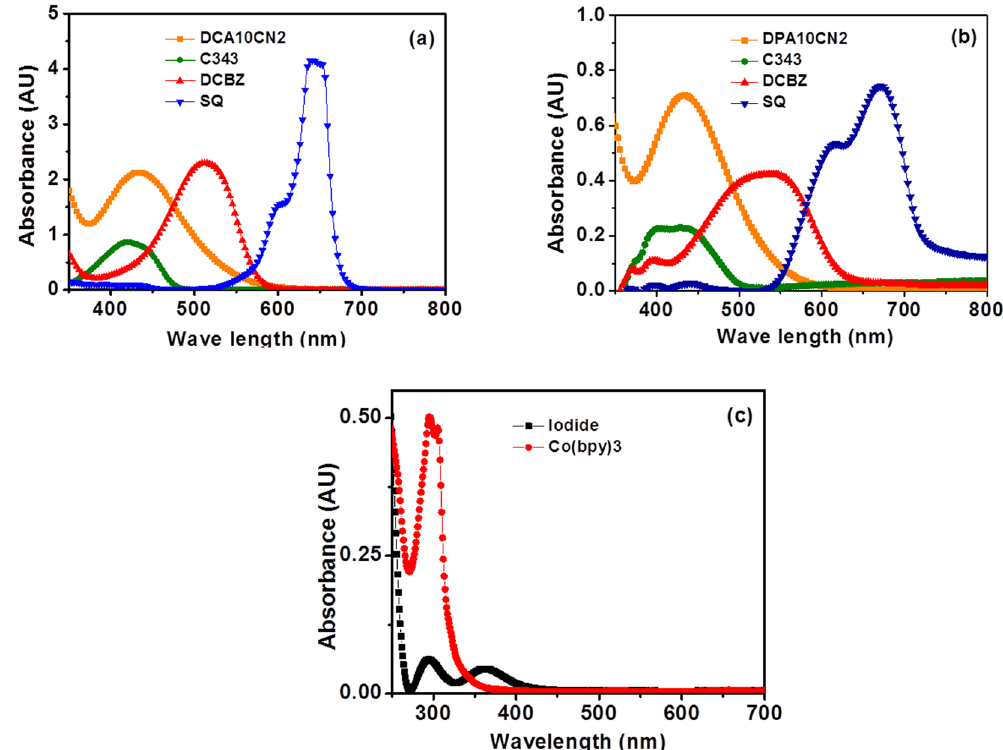
Figure 3. UV–visible absorption spectra. UV–visible absorption spectra of the dyes DCA10CN2, C343, DCBZ, and SQ ( a ) in solution and ( b ) adsorbed on photoelectrode films. ( c ) Absorption spectra of iodine and cobalt electrolytes.